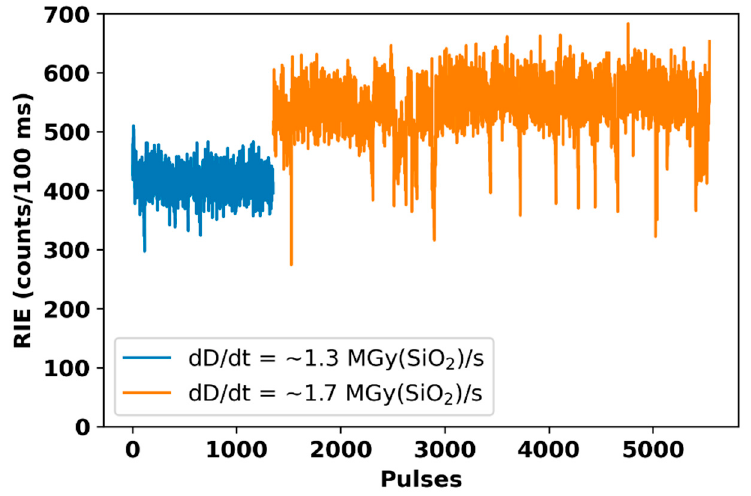
Figure 7. RIE evolution following the dose variations, as a function of the X-ray pulses. The first pulse set in blue was performed with a dose rate average of ~1.3 MGy(SiO 2 )/s, while the second set in pink was performed at ~1.7 MGy(SiO 2 )/s.